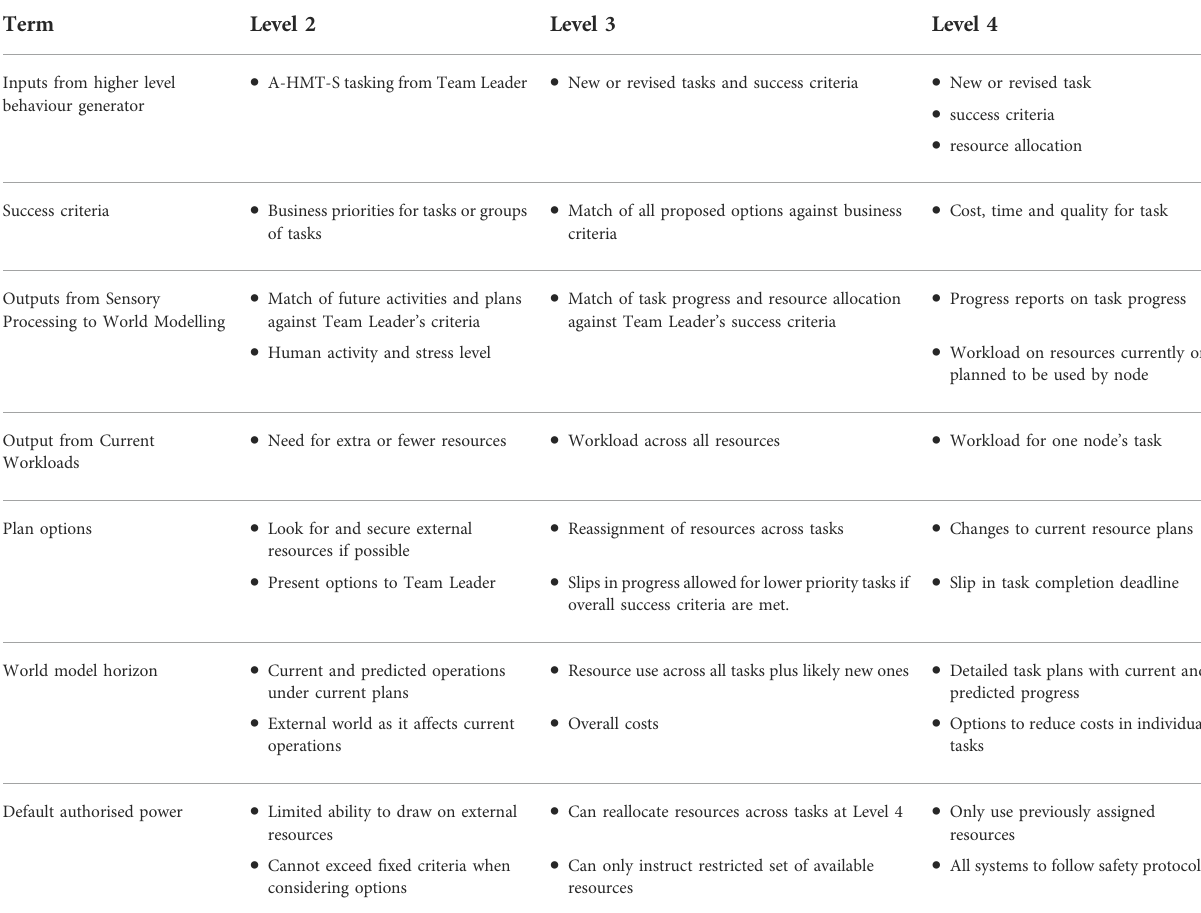
TABLE 1 Description of information used at key points in Figure 5 for different architecture